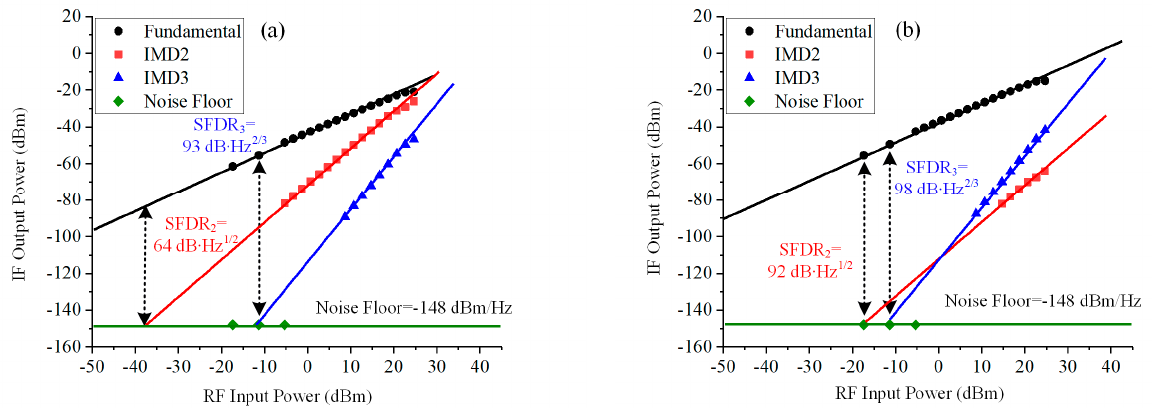
Figure 3. The SFDR measurement results ( a ) without balanced detection and ( b ) with balanced detection.